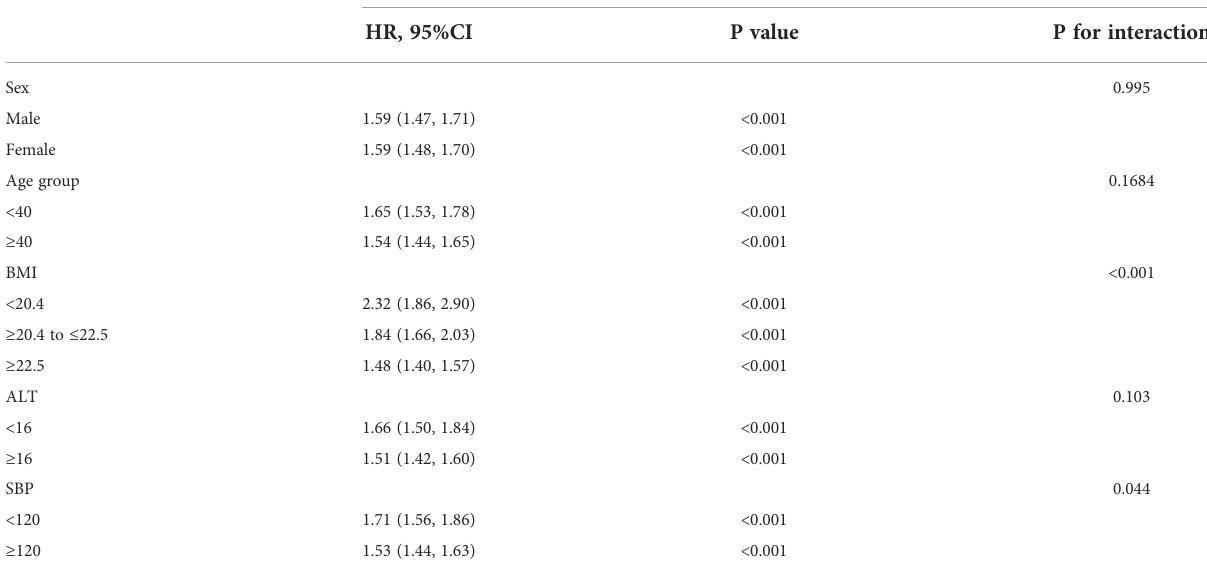
TABLE 5 Subgroup analysis for the risk of new-onset NAFLD by baseline AIP quartiles (per SD). Subgroup